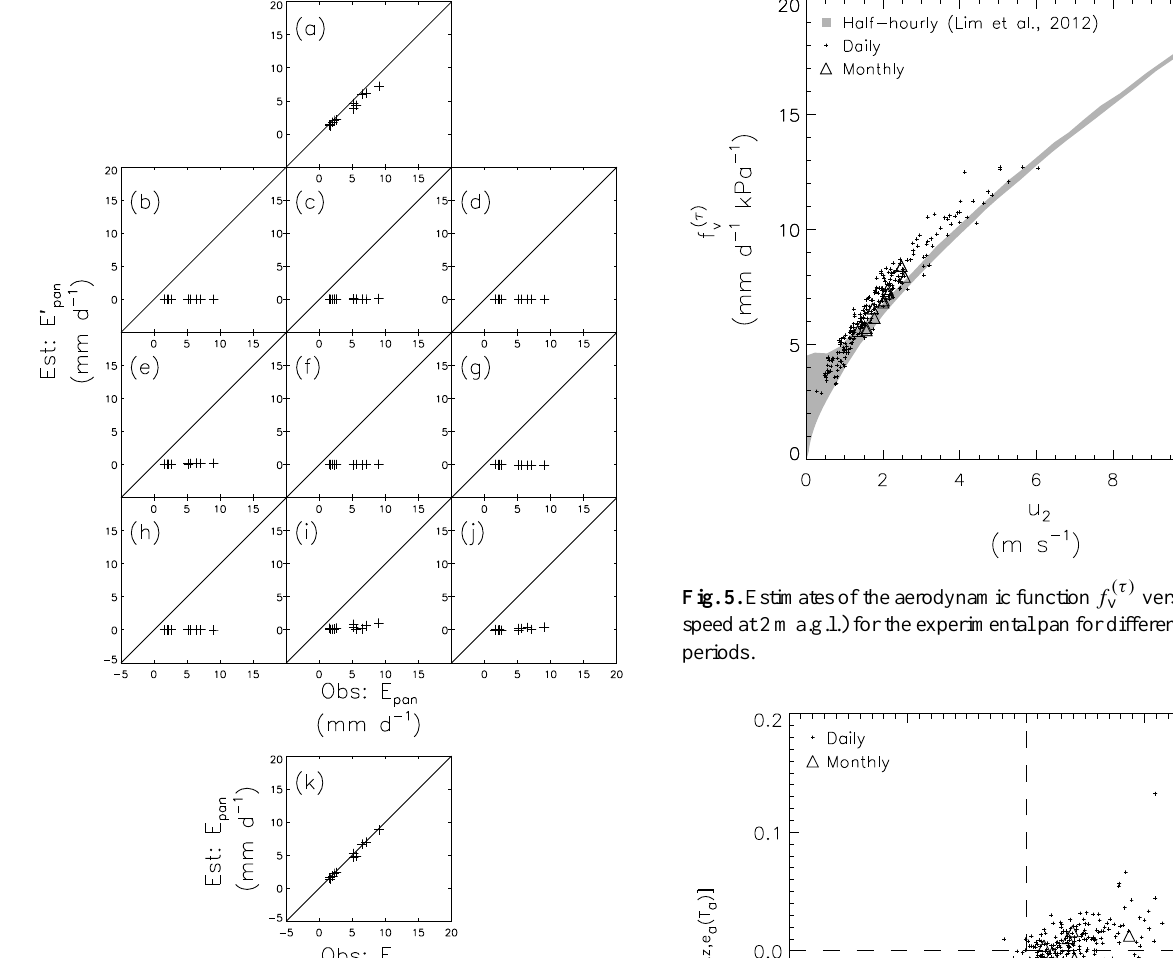
Fig. 4. Estimated E pan (Eq. 8; prime symbol (’) denotes par- tial results) versus observed E pan for 11 months (1:1 line shown): (a) E ∗ pan , (b) χ [